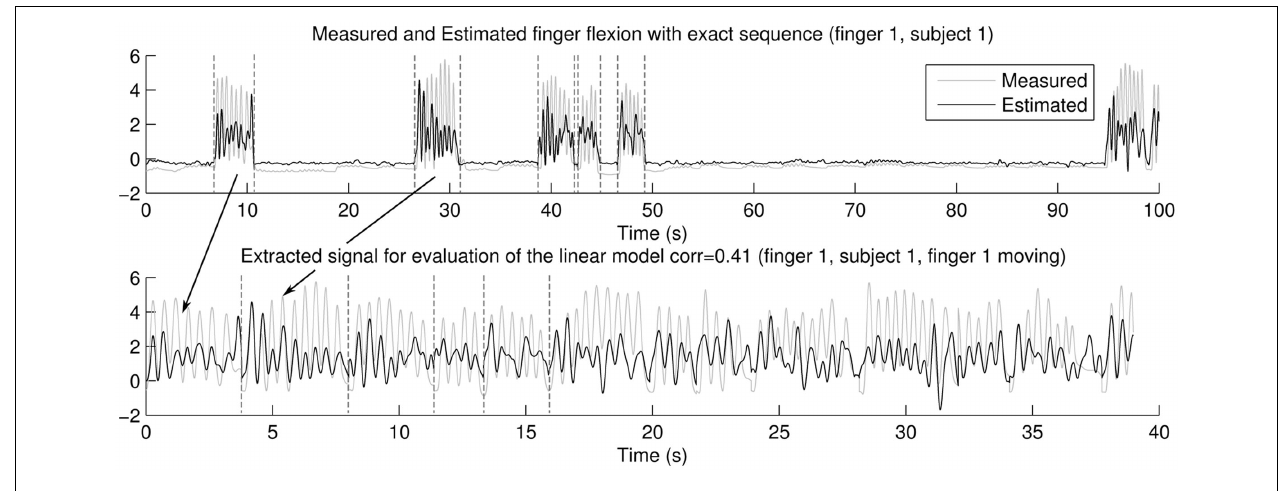
FIGURE 4 | Signal extraction for linear model estimation: (upper plot) full signal with segmented signal, corresponding to moving finger, bracketed